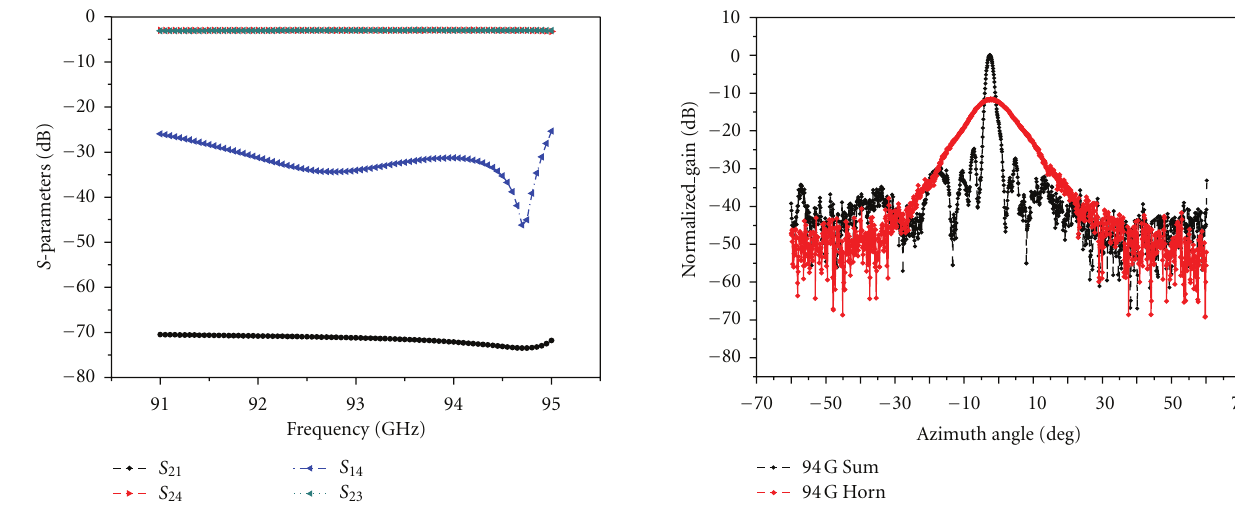
Figure 9: H-FMT isolation and transmission coe ffi cients.